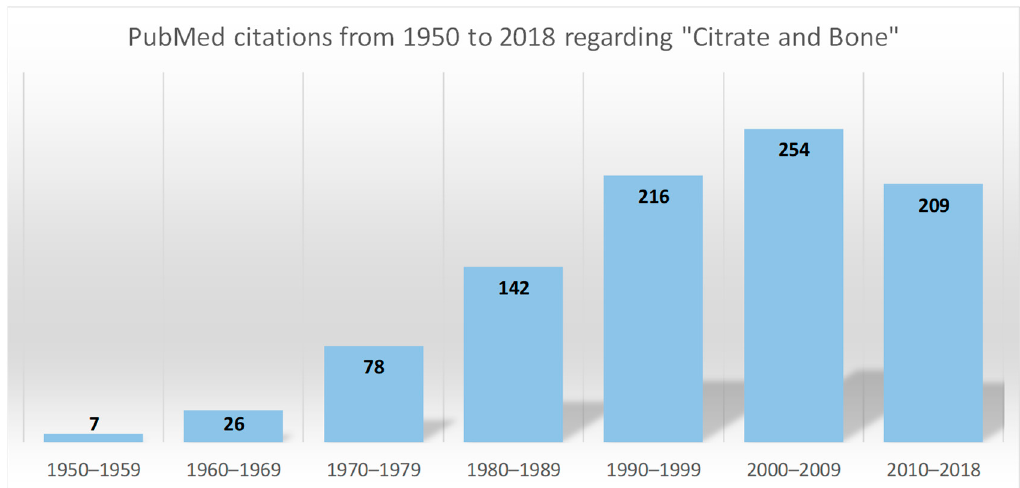
Figure 1. Distribution of the biomedical citations indexed by PubMed over seven decades ( n = 949, from 1949 to 2018). The search query focused on “citrate” and “bone”, with a search restricted to the terms “Title”, “Abstract” or “Medical Subject Headings”. Only citations related to studies on humans are included with the exception of those dealing with citrate as an anticoagulant.